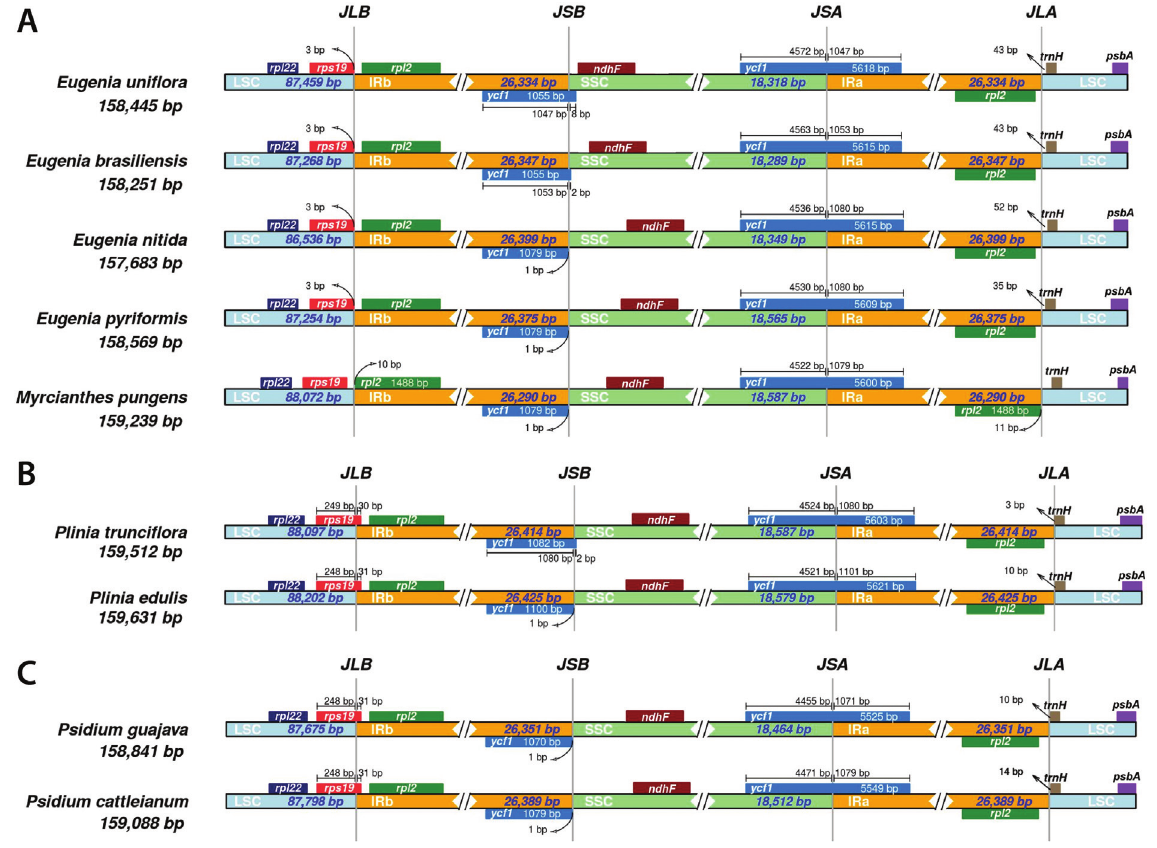
Figure 2 - Comparison of border positions of LSC, SSC and IR among (A) Eugenia uniflora , (B) Psidium guajava and (C) Plinia trunciflora and related new species. JSA/JSB, junction of SSC-IRa/IRb; JLA/JLB, junction of LSC-IRa/IRb. Boxes above or under the main line indicate the predicted genes; ycf1 pseudogenes are at JSB and their lengths are displayed in the corresponding regions. The figure is not to scaled, and shows relative changes at or near the IR-SC borders.